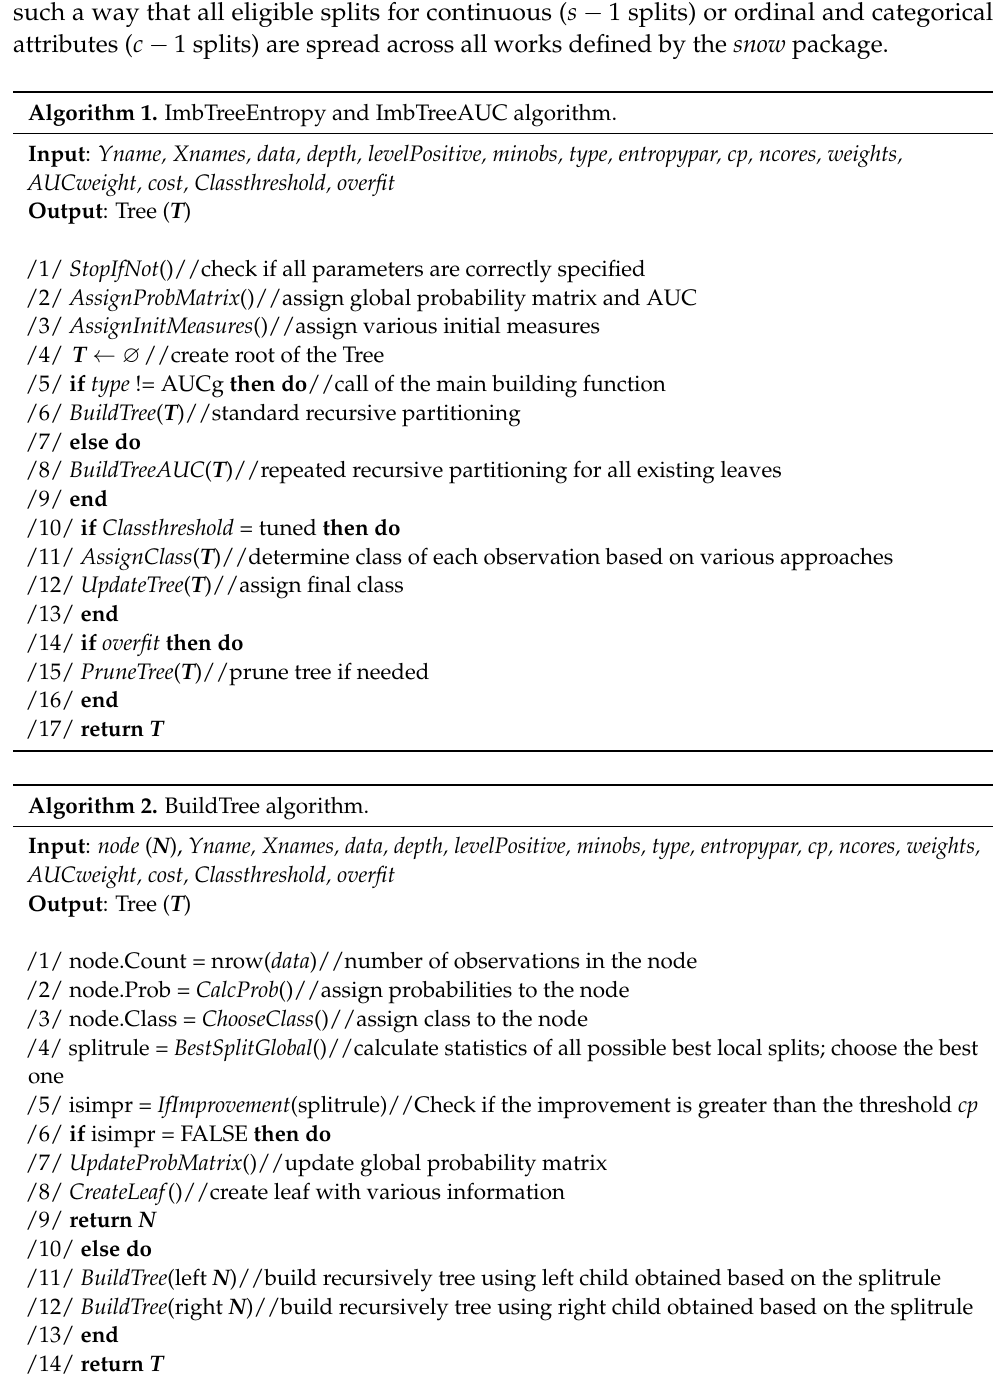
Algorithm 2, calculate the number of observations in the node, vector with probabilities of each class (base version or based on the costs/weights), and based on this vector, the final class label is derived. In step 4, the most computationally demanding BestSplitGlobal () function is called. It calculates the best attribute for splitting (along with the best split